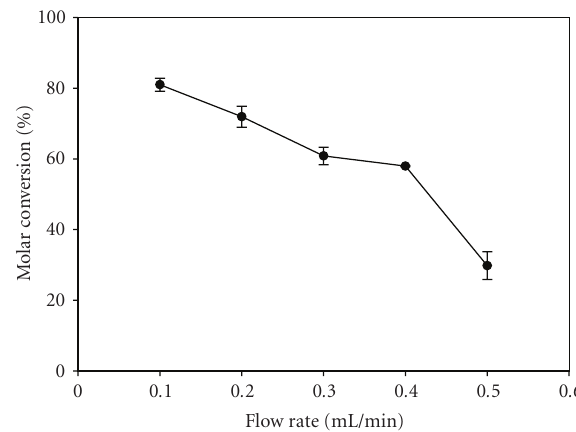
Figure 1: The e ff ects of flow rate on the conversion of soybean oil to biodiesel. Reaction conditions: temperature 50 ◦ C, substrate molar ratio 1:4, and 1.7 g